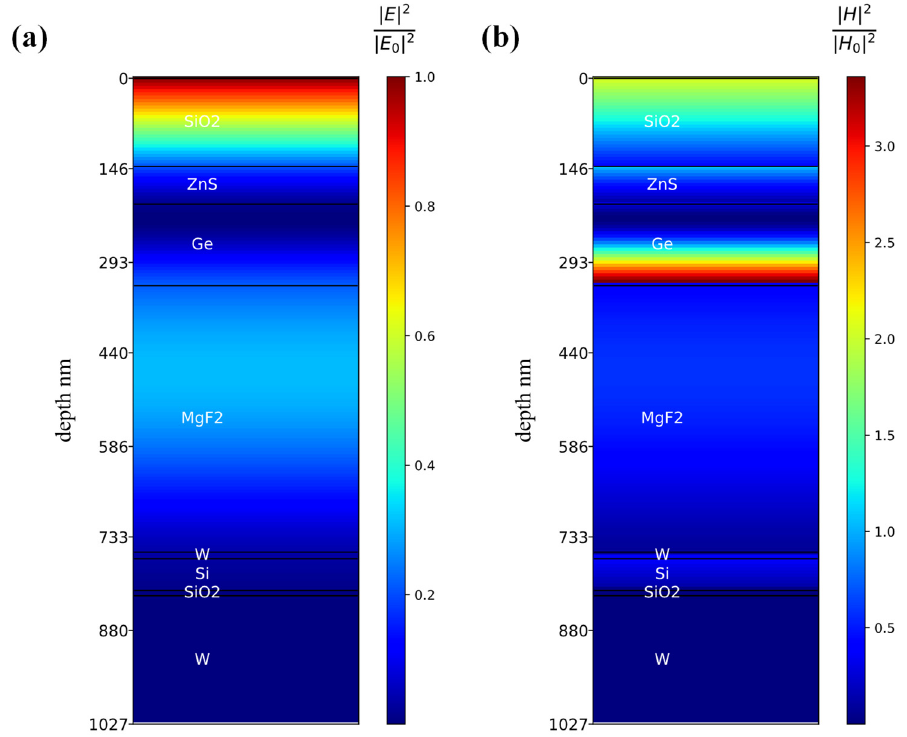
Figure 8. ( a , b ) Contour of normalized electric and magnetic field intensities for our optimal struc- ture.